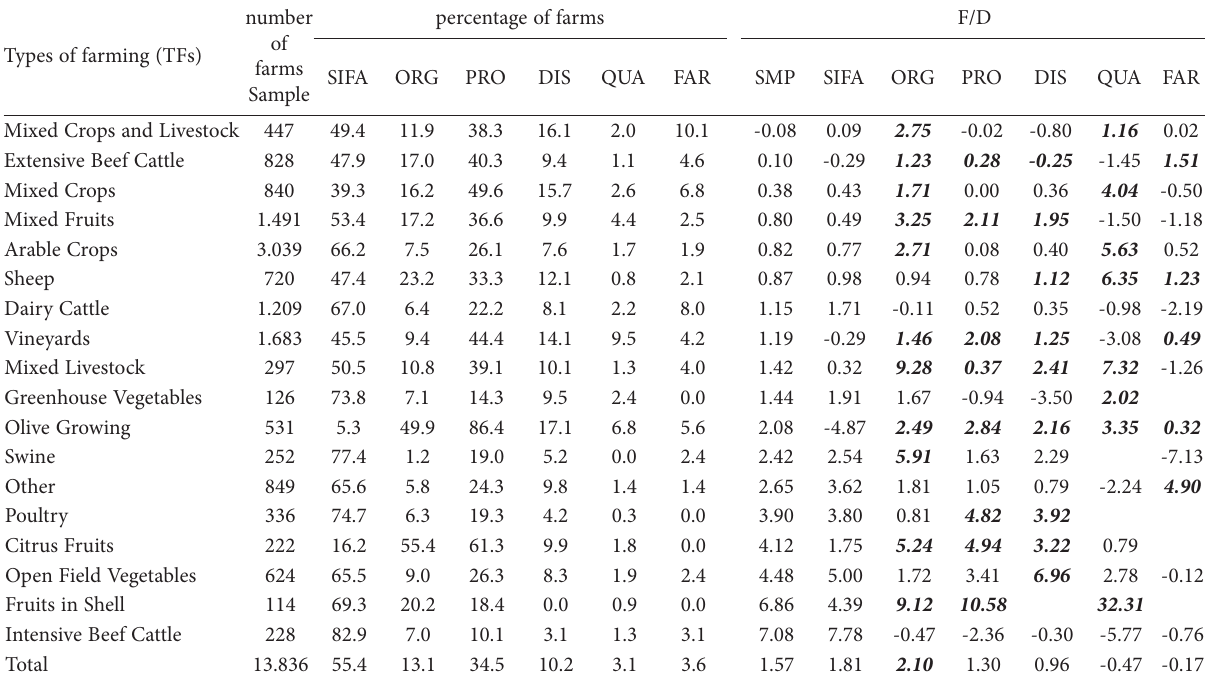
Table 4. Number of farms (sample), percentage of farms (by TF, simple farming and agribusiness ), value of the financial sustainability index (by